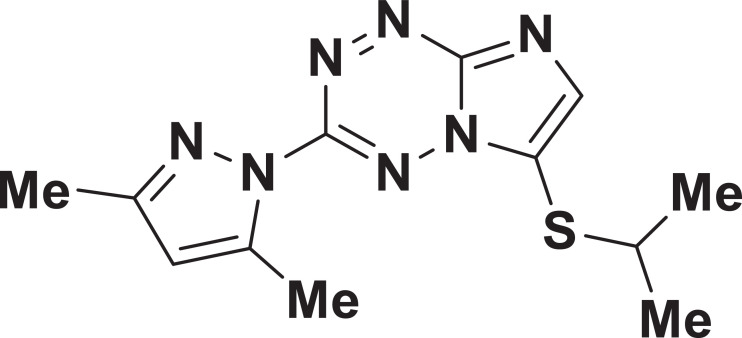
Chemical structures of the compound 3a [1].